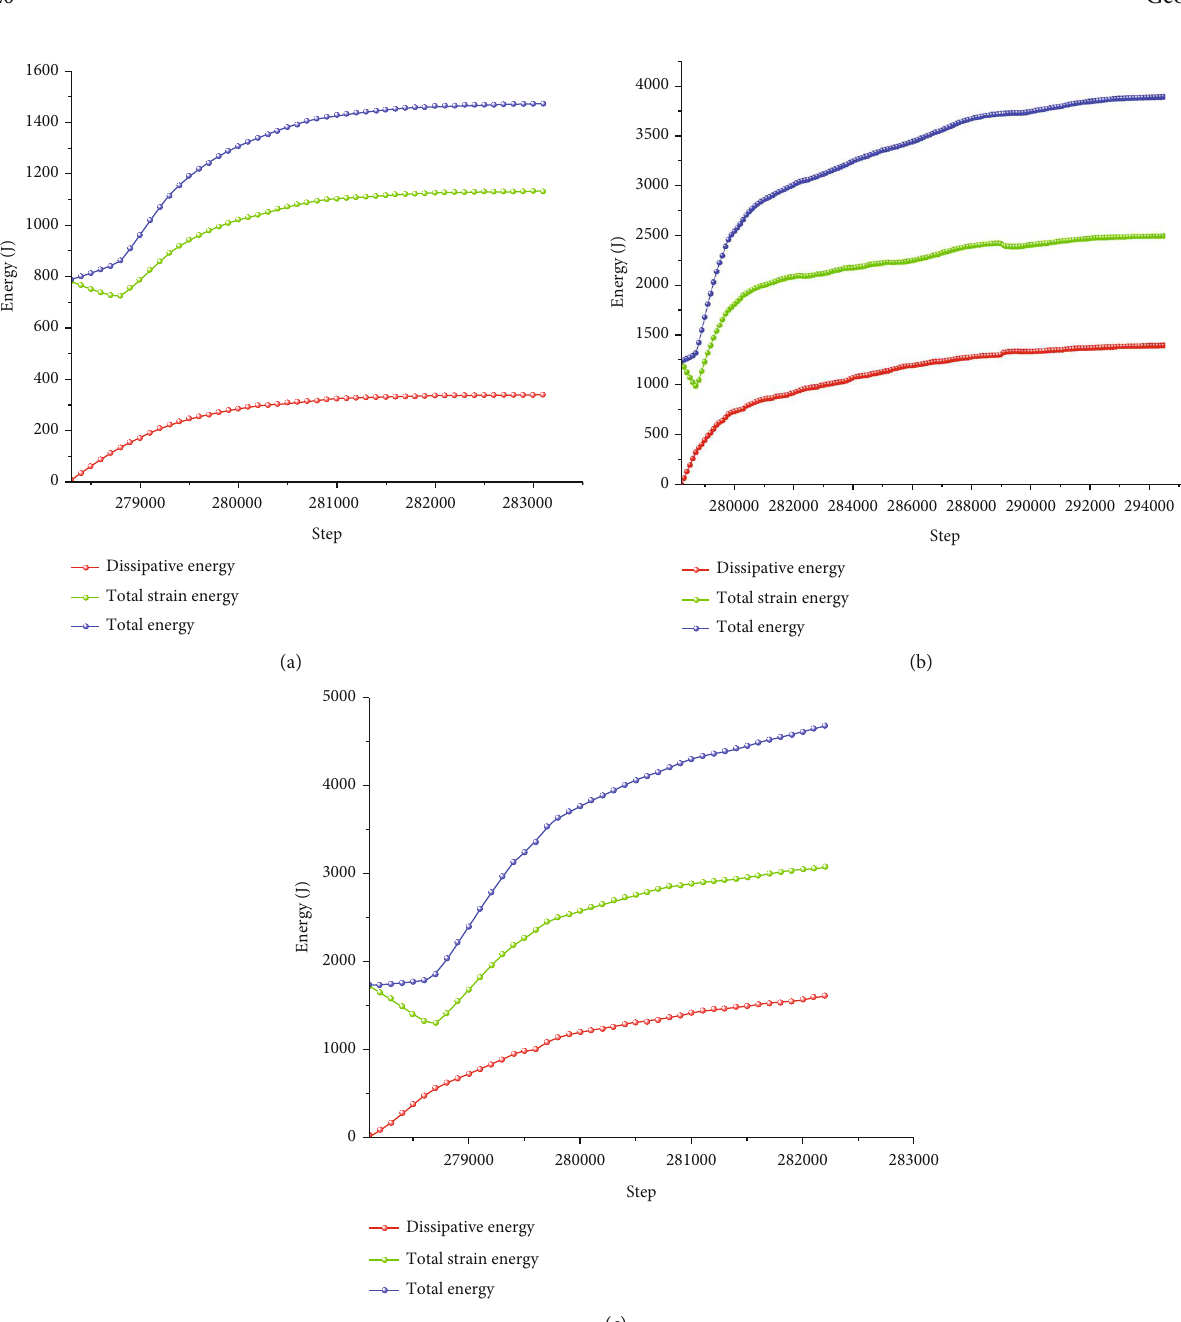
Figure 14: Energy change diagrams under partial horizontal stress combination conditions. (a) σ MPa, σ H = 80MPa . (c) σ V = 60 MPa, σ H = 100MPa